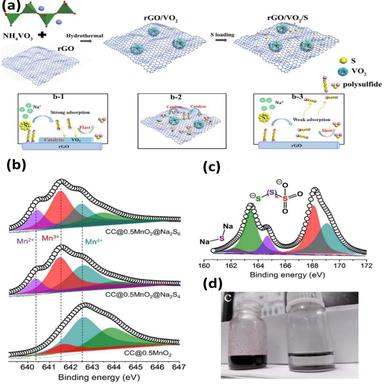
a) Schematic illustration of the synthesis of rGO/VO2/S composite and its advantages. Reprinted (adapted) with permission from Ref. . Copyright 2019 Elsevier. b) Mn 2p3/ 2 spectra of CC@0.5MnO2, CC@0.5MnO2@Na2S4, and CC@0.5MnO2@Na2S6, c) S 2p3/2 spectrum of CC@0.5MnO2@Na2S6 and d) digital photograph showing the variation of the polysulfide solution with the addition of MnO2 catalyst, in polysulfide solution. Reprinted (adapted) with permission from Ref. . Copyright 2019 Elsevier.